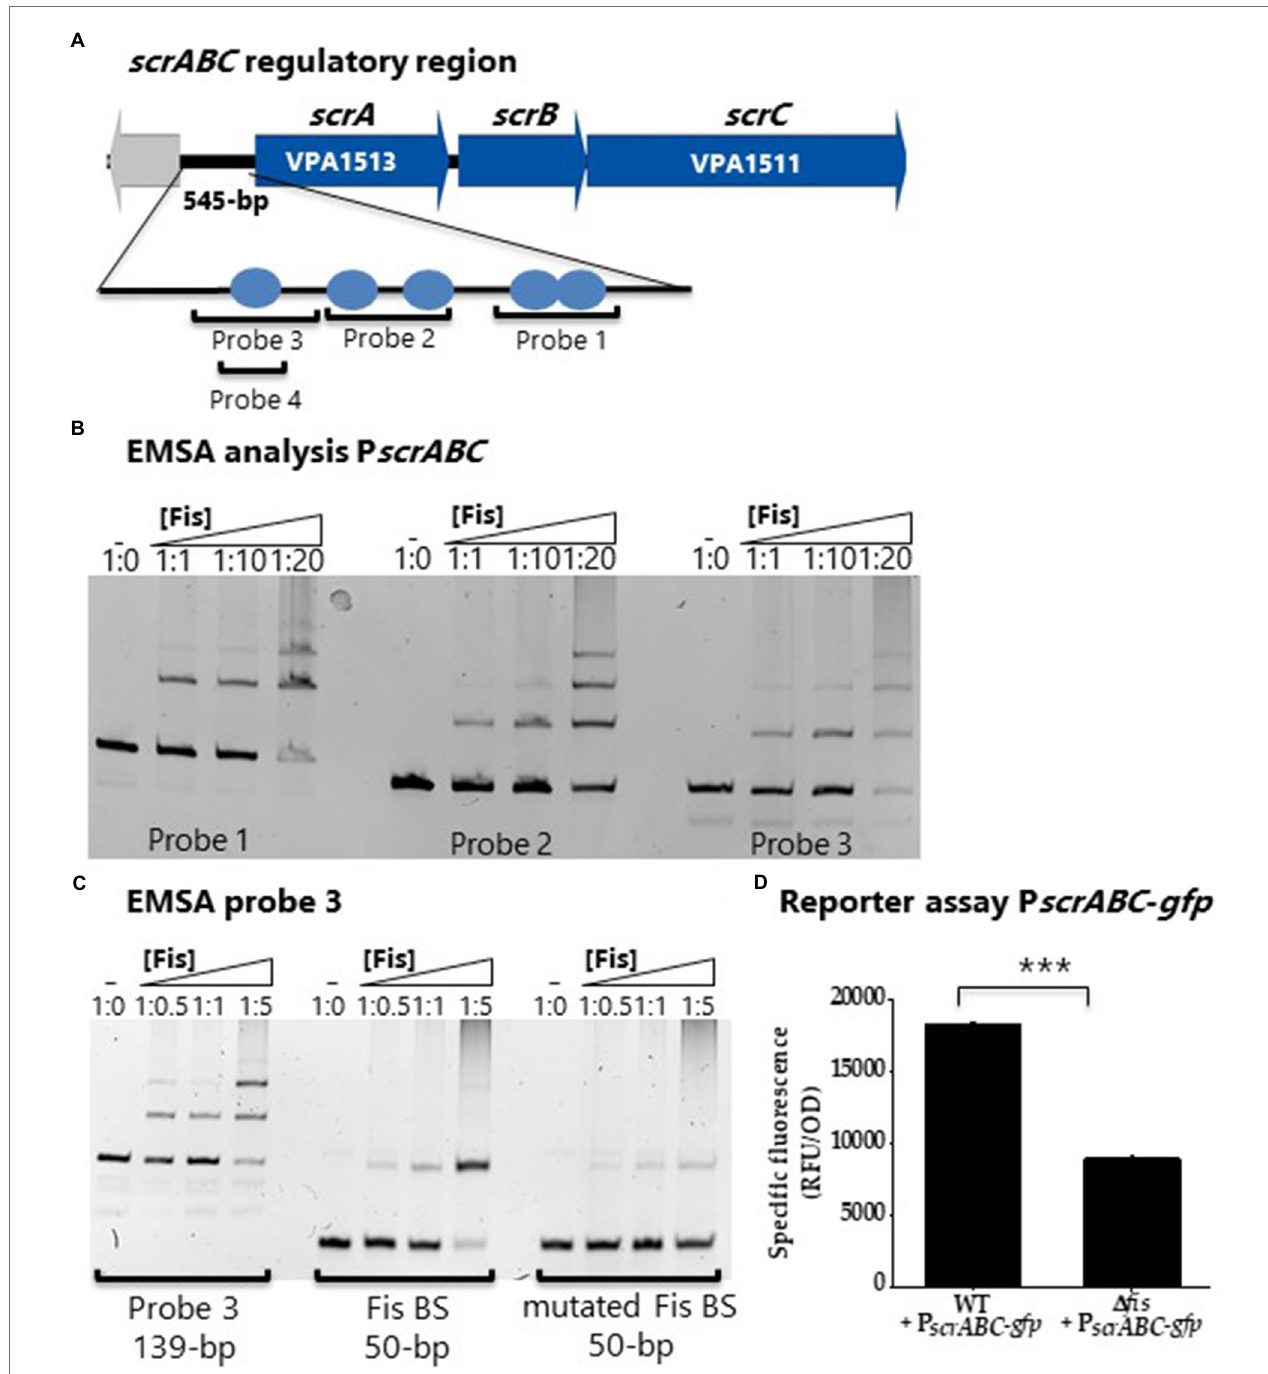
FIGURE 6 | Fis is a positive regulator of the surface sensing operon, scrABC . (A) Putative Fis binding sites identified in the regulatory region of the scrABC surface sensing operon. (B) EMSA using purified Fis protein and probes 1, 2 and 3 encompassing the regulatory region of scrABC . DNA: protein ratios are as follows: 10, 1:1, 1:10, 1:20, 1:50. (C) Probe 3 containing a single Fis BS and a mutated probe 3 Fis BS. DNA: protein ratios are as follows: 0, 1:0.5, 1:1, 1:5. (D) GFP reporter assay of P scrABC - gfp in wild type and the Δ fis mutant. Specific fluorescence was calculated (RFU/OD) for three biological replicates and plotted as mean and standard deviation. Statistics were calculated using a Student’s t -test (*** p <